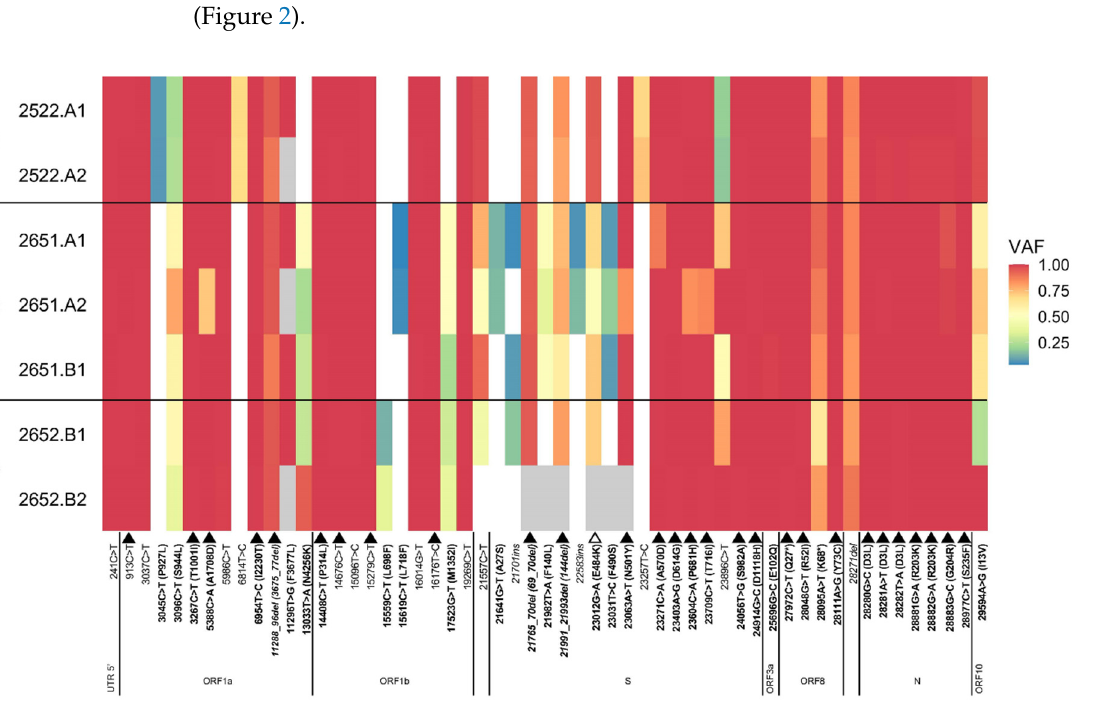
Figure 2. SARS-CoV-2 variant allele frequencies (VAFs) across time points, from nasopharyngeal samples. Only mutations shared by at least two replicates of the same time point are shown. The reference allele corresponding to the Wuhan-Hu-1 genomic sequence MN908947.3 is indicated in white. Missing VAF values, corresponding to positions with low coverage (<20X), are depicted in grey. On the y -axis, A and B indicate slightly different protocols (see Materials and Methods), while A1/A2/B1/B2 identify distinct replicates. On the x -axis, non-synonymous mutations are in bold and reflect the amino acid change, synonymous mutations are represented only by the nucleotide change, and insertions and deletions are in italic. Filled black triangles highlight mutations specific to the SARS-CoV-2 Alpha variant (B.1.1.7), while the open black triangle highlights the E484K